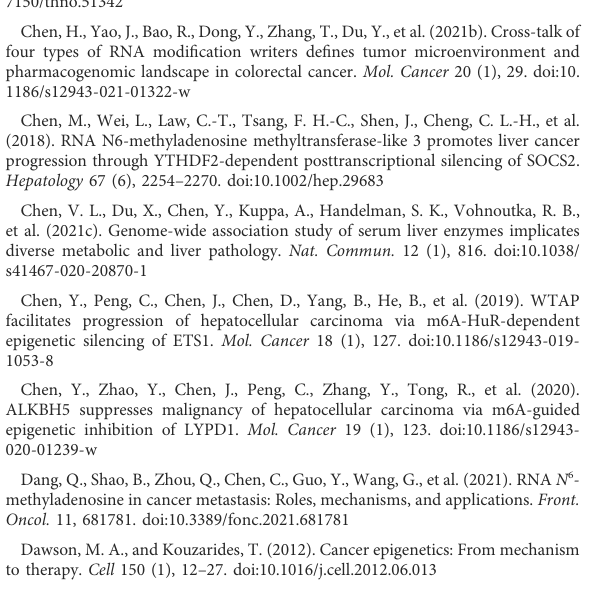
SUPPLEMENTARY FIGURE S4 Expression of immune-in fi ltrating cells in two m6A gene clusters based on ssGSEA, MCP-counter, TIMER, and xCell, respectively. SUPPLEMENTARY FIGURE S5 Expression of immune-in fi ltrating cells in high- and low-m6Ascore groups based on ssGSEA, MCP-counter, TIMER, and xCell, respectively. SUPPLEMENTARY FIGURE S6 Mutation landscape underlying m6A